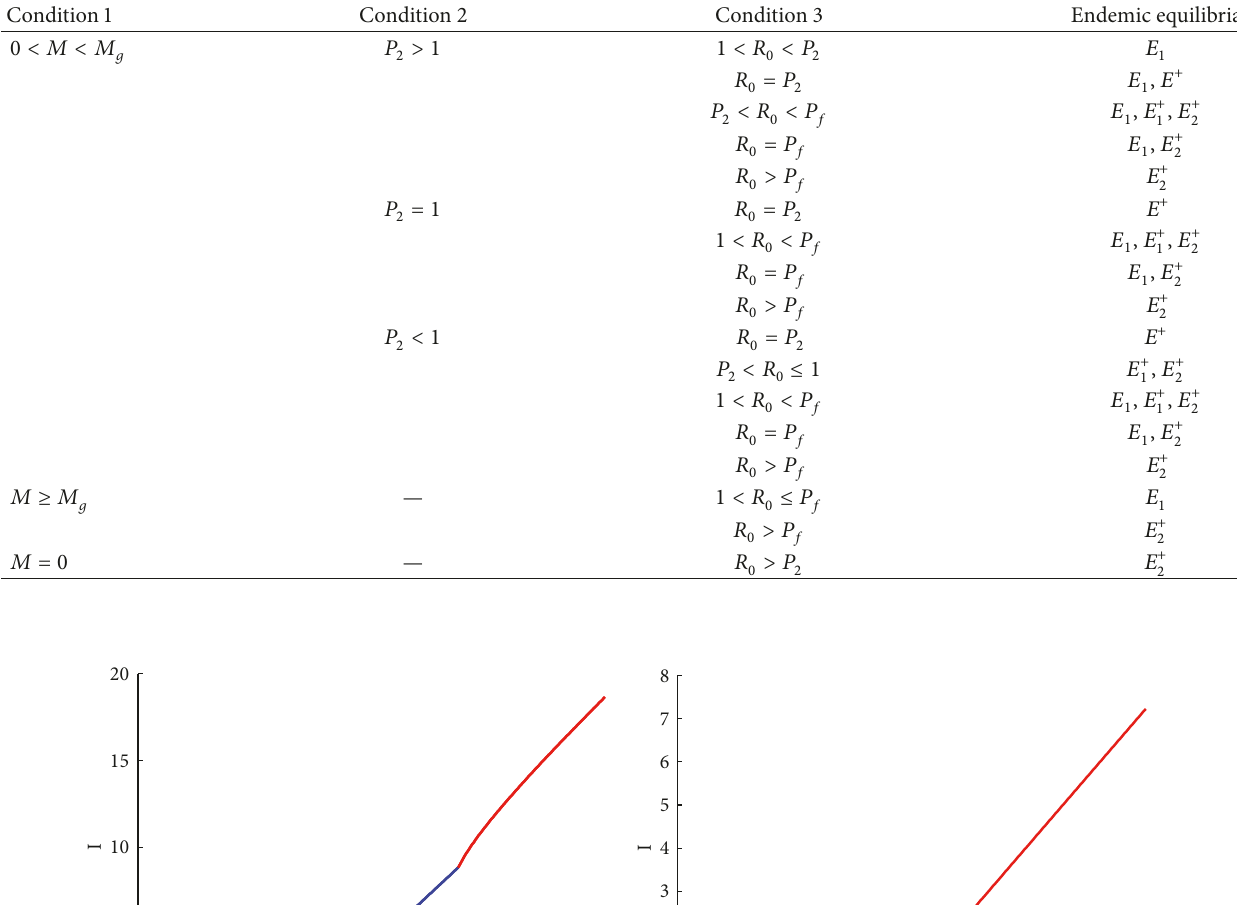
Table 5: Existence of endemic equilibria of model (4).